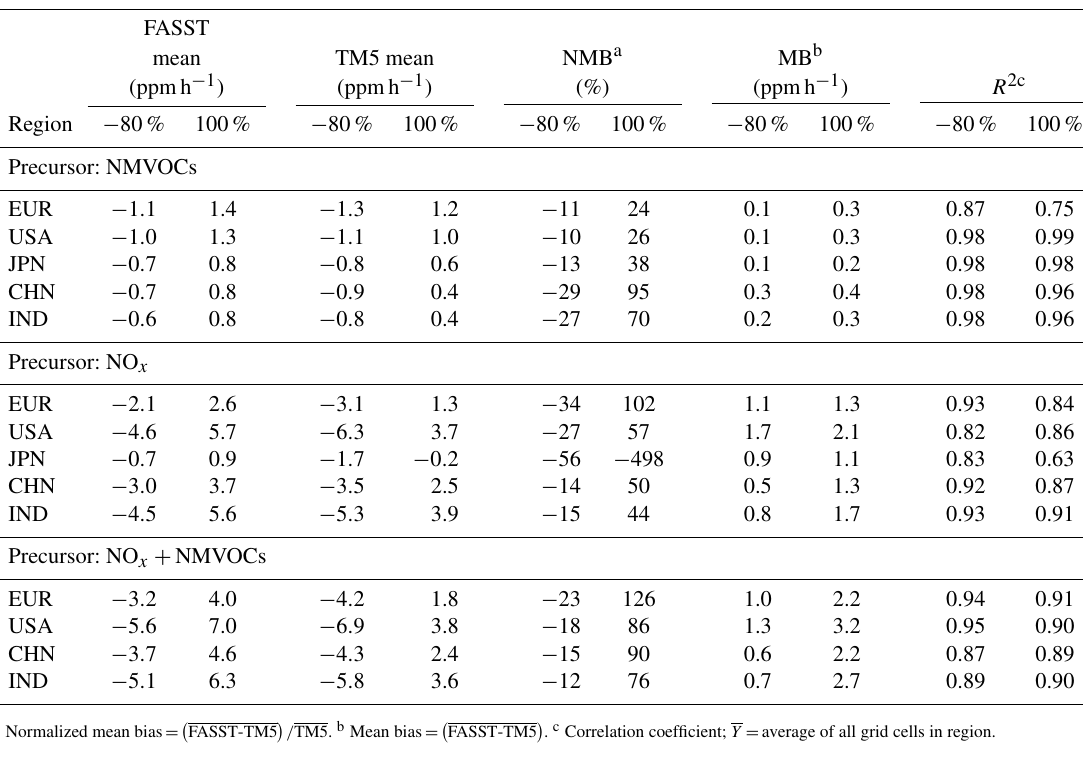
Table 6. Statistical metrics describing the correspondence between the linearized FASST- and TM5-computed change in O 3 crop exposure metric AOT40 upon − 80% and 100% emission perturbation in its precursors (NMVOCs, NO x , and combined NO x + NMVOCs), relative to the RCP2000 base scenario. Statistics are calculated over all 1 ◦ × 1 ◦ grid cells in each region.